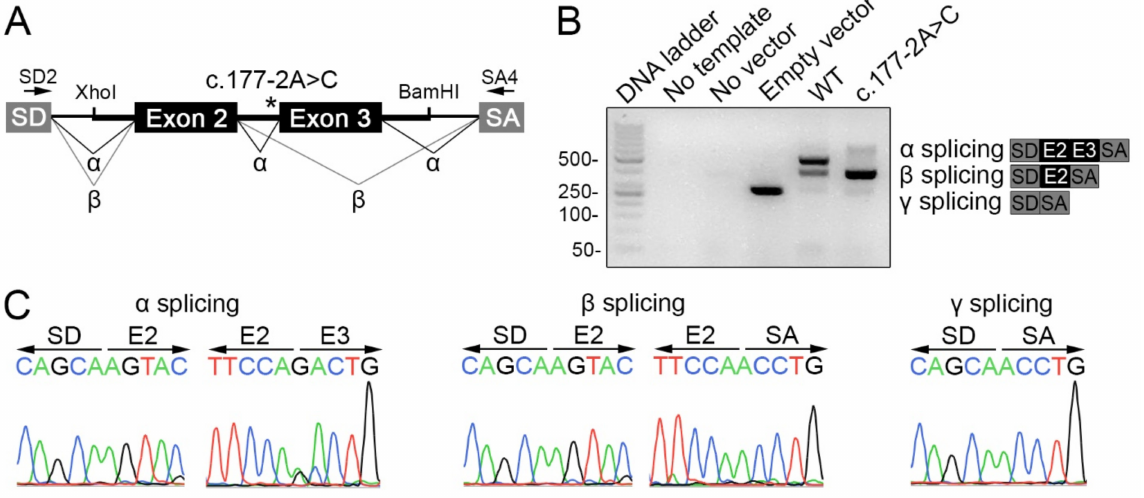
Figure 2. The variant c.177-2A>C causes exon 3 skipping during TG pre-mRNA splicing. ( A ) Scheme of pSPL3-based minigenes used in functional assays. The genomic fragment containing exons 2 (109 bp) and 3 (98 bp) along with a portion of the flanking introns 1 and 3 (247 and 236 bp,